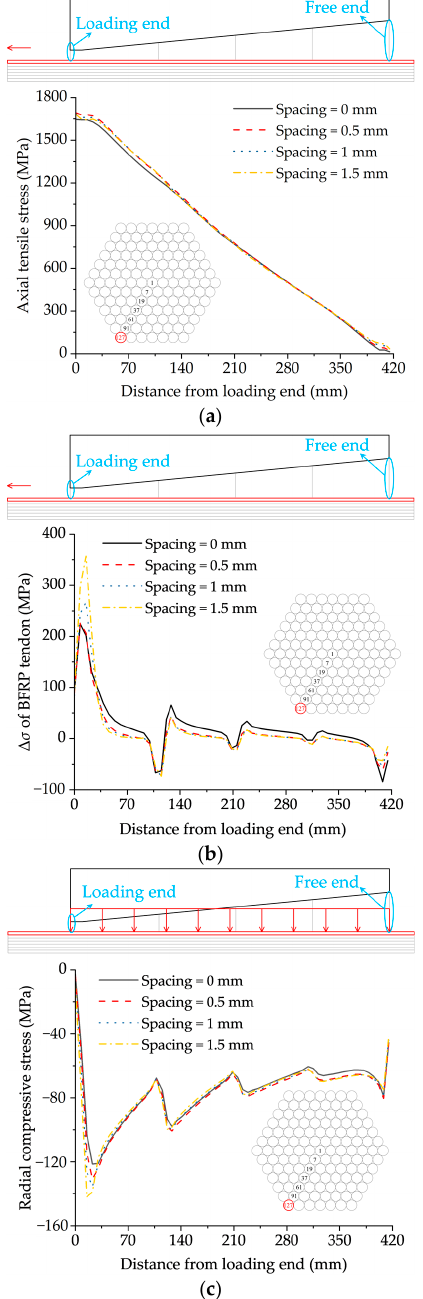
Figure 8. Simulated results of full model with tendon spacing: ( a ) axial tensile stress, ( b ) Δσ of BFRP tendon, and ( c ) radial compressive stress. tendon, and ( c ) radial compressive